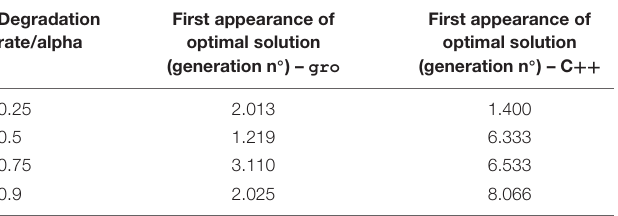
TABLE 7 | Temperature decrease rate variation for